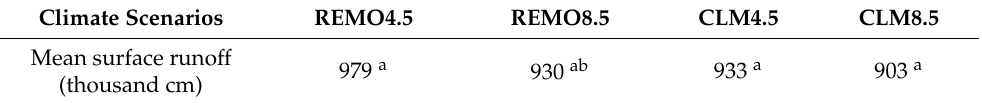
Table 3. Testing influence of climate change scenarios on surface runoff.